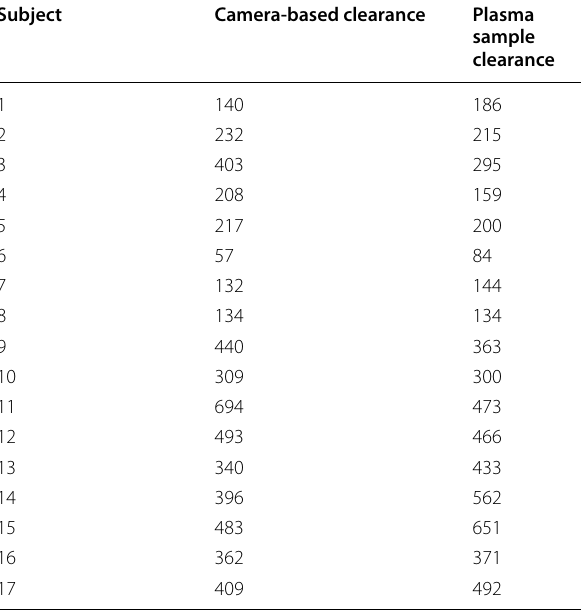
Table 4 Camera-based and plasma sample clearance of NTA